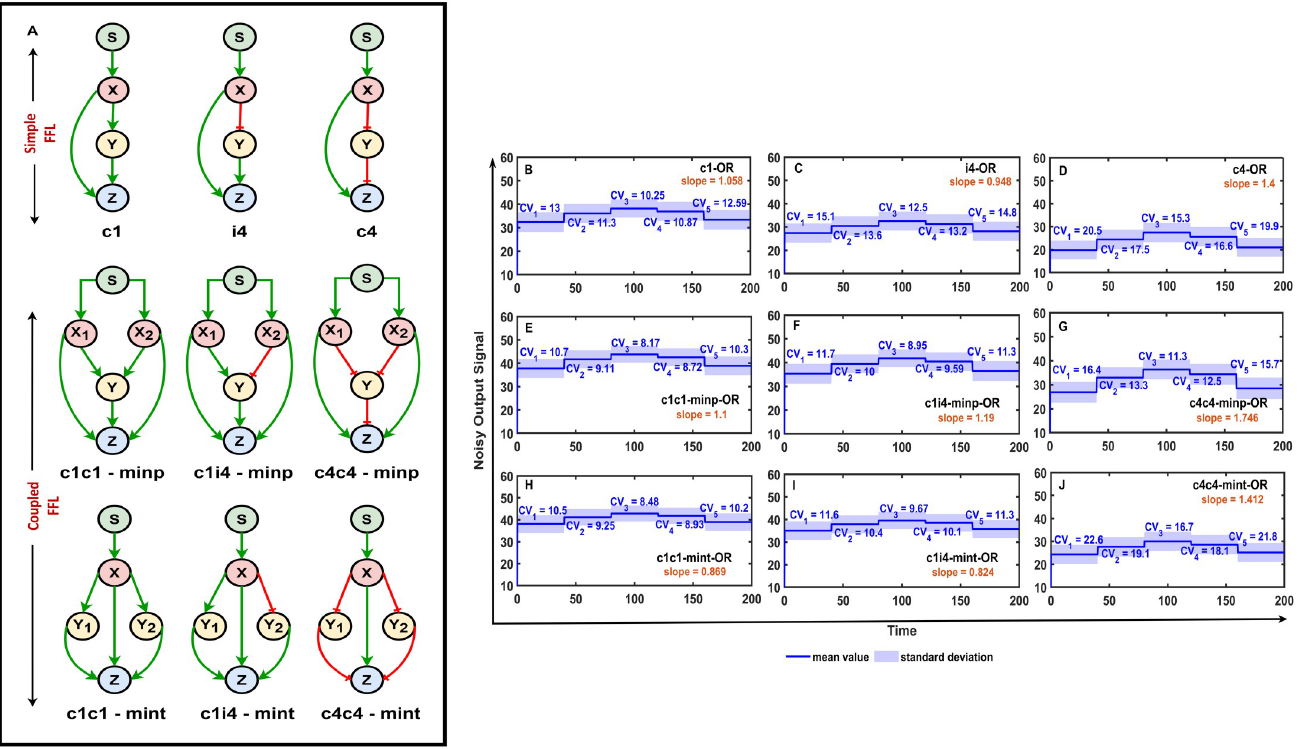
Fig 4. Comparison of noise reducing and signal transducing performance of the best performing FFL motifs. The best performing simple and combined FFL networks are plotted in (A). The corresponding panels with similar layout (B-J) show the performance of each of these networks for the input change presented in Fig 1F. The mean of the output active forms of Z molecules of panel A are plotted with solid blue lines, ± standard deviation is plotted with shading, and coefficient of variation in percentage (% CV) values and slopes of input-output relation curves are labeled on all plots. All simulations were run with one-step post-translational modification models and the fixed parameter sets presented in the S1